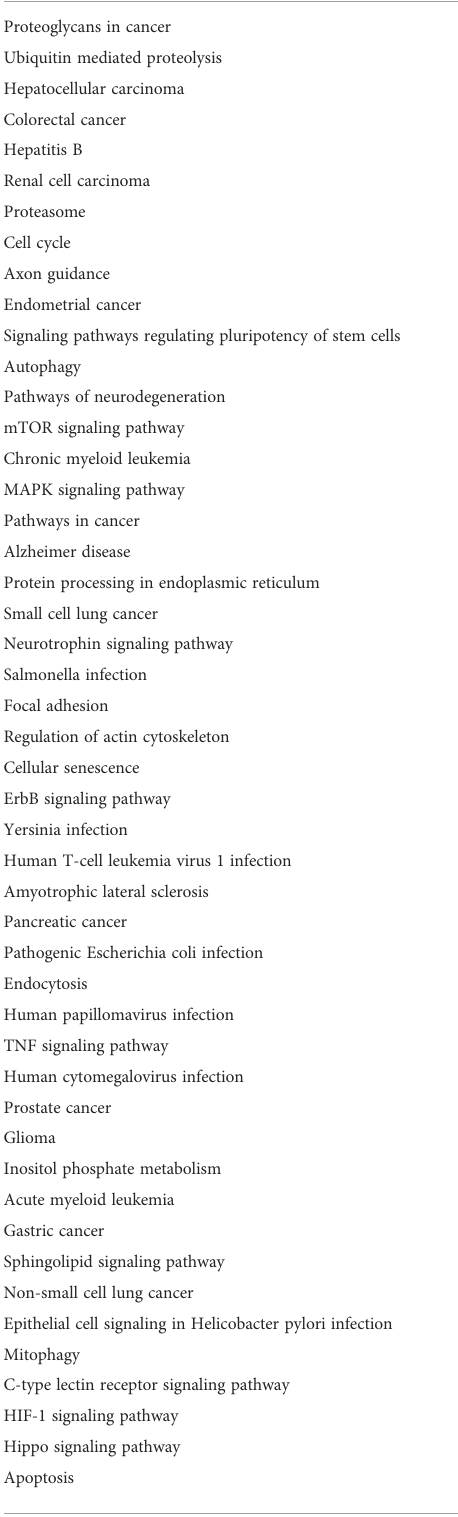
TABLE 2 KEGG terms of genes differentially expressed in wild type and Pkd1 -/- mDCT15 cells. KEGG pathway